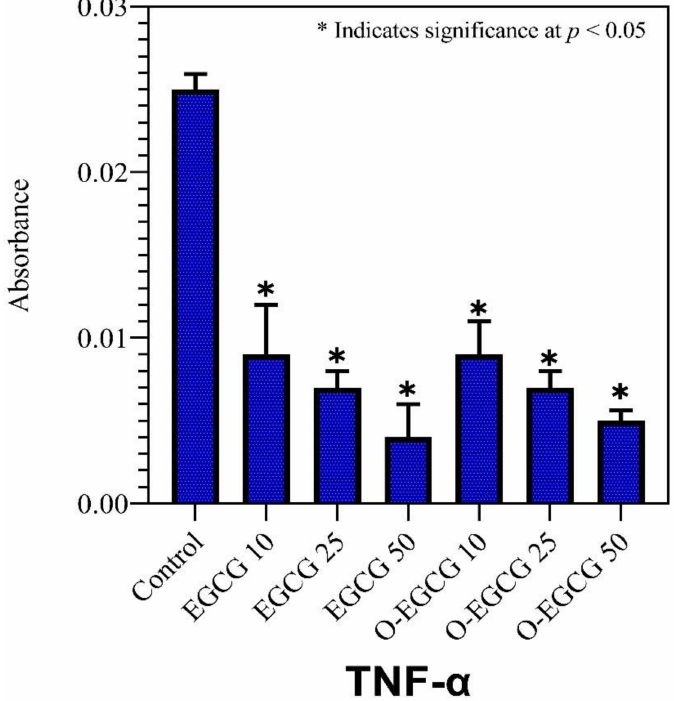
Figure 7. The effect of EGCG and O-EGCG on TNF- α production in HCT-116 cells. (* indicates significance at p <